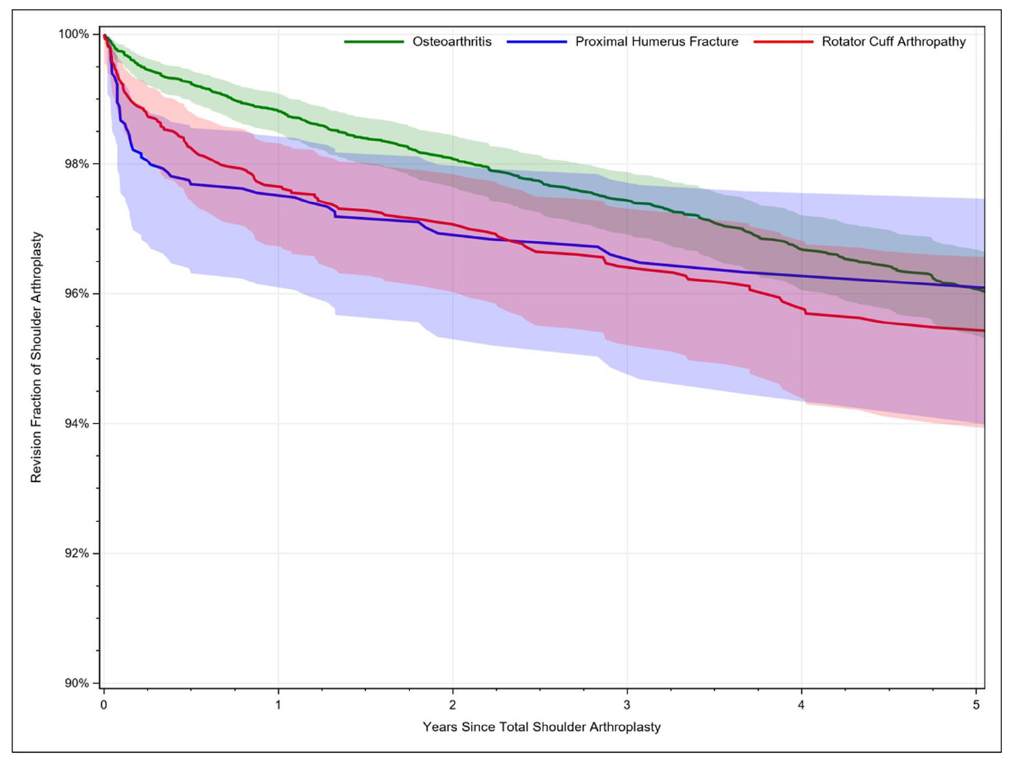
Figure 1. Comparison of revision rates after total shoulder arthroplasty by indication. The unrevised fraction of patients with osteoarthritis is shown in green, patients receiving treatment for proximal humerus fractures in blue and patients receiving rotator cuff-related arthroplasty in red. Table 1. Comparison of risk for a revision after shoulder arthroplasty between patients treated for osteoarthritis, proximal humerus fracture and patients receiving rotator cuff-related arthroplasty. HR = hazard